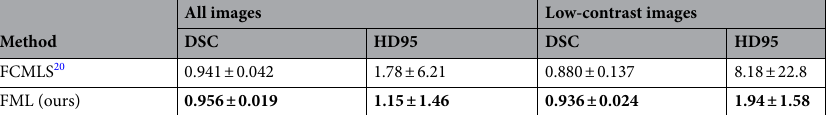
Table 1. Comparison between the segmentation accuracy of the FML and FCMLS methods. Significant values are in [bold].